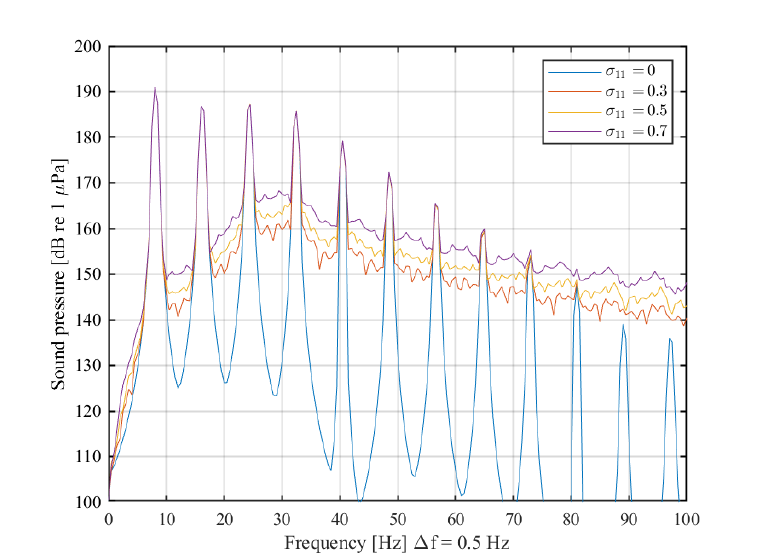
Figure 12. Sound pressure spectra of artificial signals generated by variation of the 11 th control point defining the collapse region based on three different standard deviations σ 11 in comparison to the unvaried signal (blue line) for 96.5 rpm.